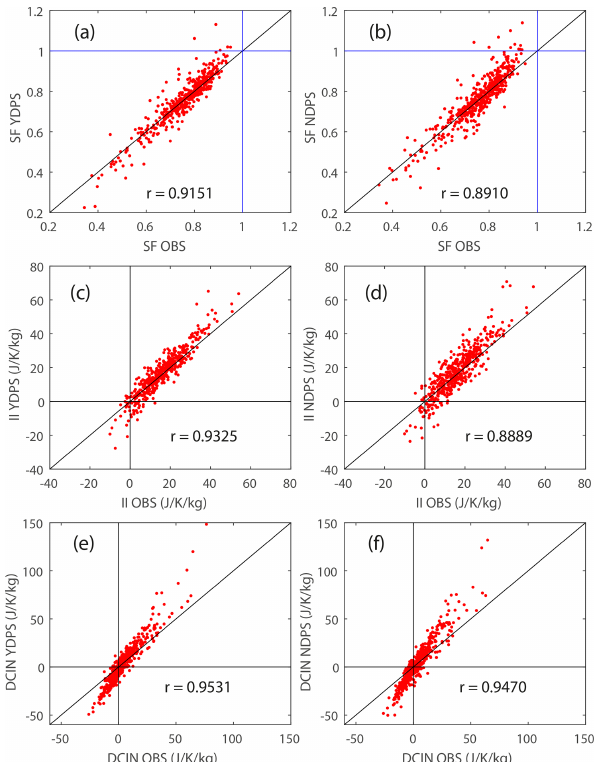
Figure 11. ECMWF model time series composites of (a) mois- ture convergence, (b) infrared temperature (from satellite observa- tions), (c) saturation fraction, (d) instability index, and (e) DCIN. Non-convective time series, defined as having moisture conver- gence lower than 0.5kWm − 2 , are shown in black, while convec- tive time series, defined as having moisture convergence larger than 2.0kWm − 2 , are shown in red. Convective time series (red) are also decomposed into the eastern Pacific box (blue) and the Colombian box (green). Vertical thin black lines indicate the period when the dropsondes were deployed in most research